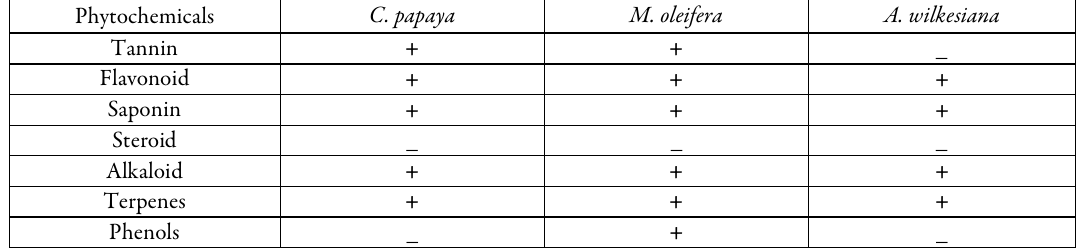
Table 1. Phytochemical constituents of the three aqueous leaf extract tested Phytochemicals